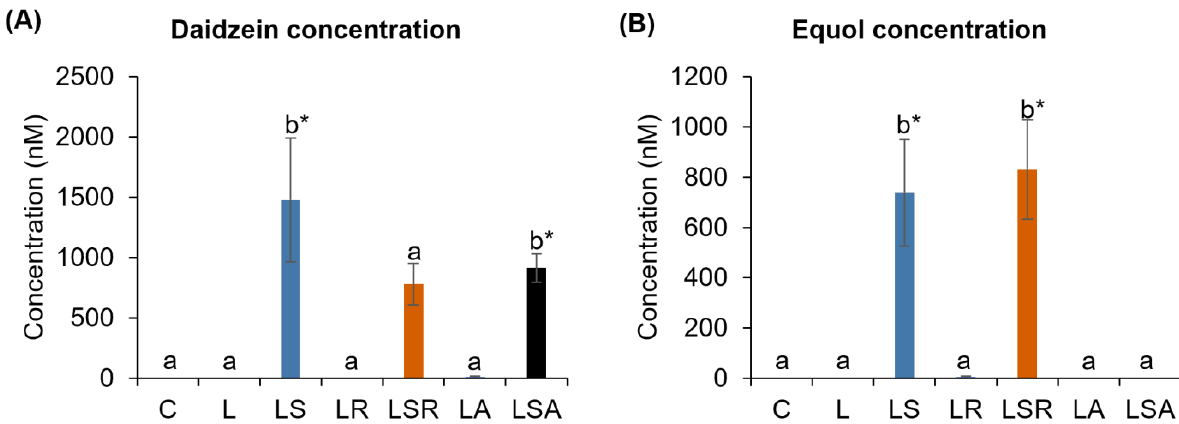
Figure 5. Daidzein and equol concentration analyses. Soy isoflavone metabolite concentrations in plasma were analyzed via HPLC. ( A , B ) show daidzein and equol concentrations, respectively. All the values are expressed as the mean ± S.E. Statistical analysis was conducted by one-way ANOVA followed by Dunnett’s test for multiple comparison analysis. a, b represent p < 0.05 compared to the C group, * represent p < 0.05 compared to the L group.